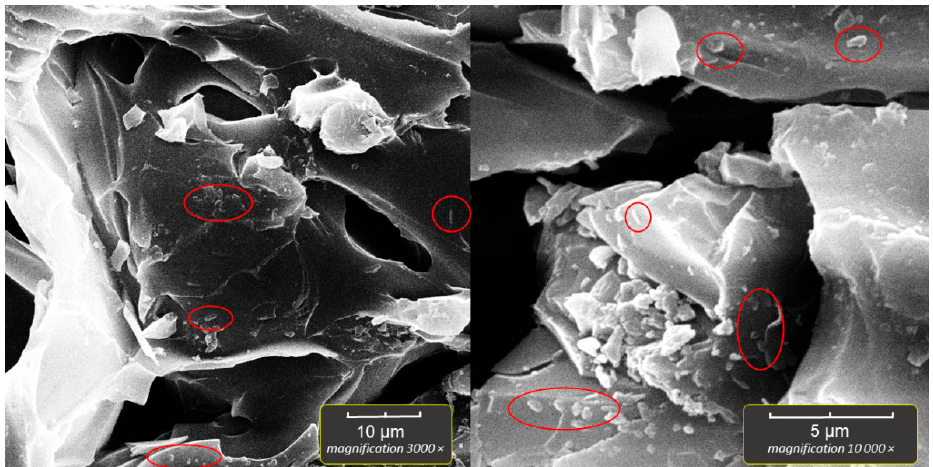
Figure 7. SEM image of bacteria immobilized on perlite in an experimental setup without aeration (anaerobic) and with Olive Cake (OC) consortium.